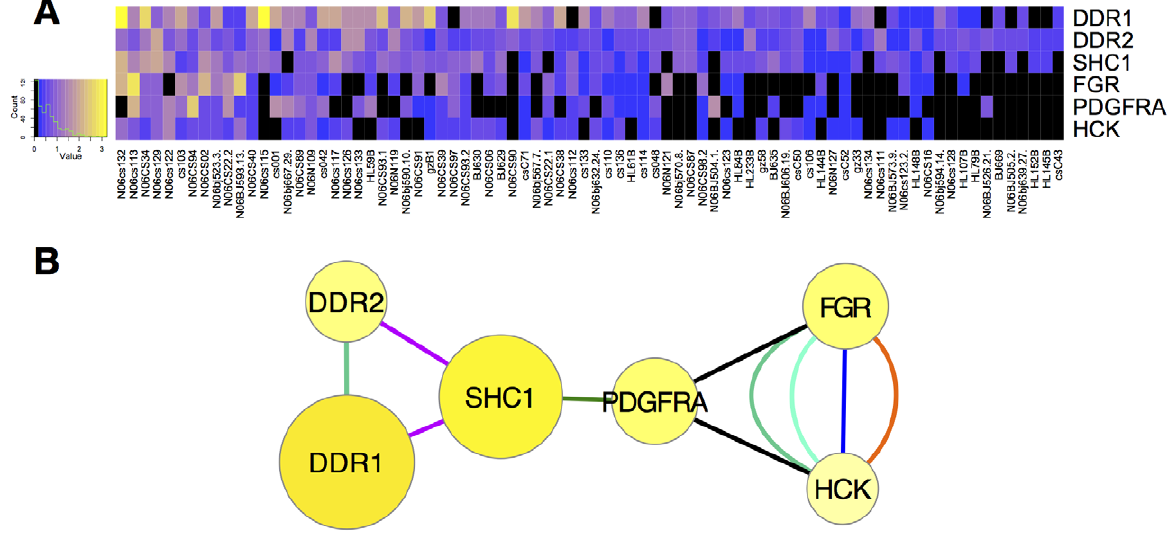
Figure 6. Filtered cluster containing DDR2. ( A ), graphed as a heat map; and ( B ), graphed as a network as in Figure 5, except additional edges are included from GeneMANIA: black – genetic interactions; dark turquoise – shared protein domains; violet – physical interactions; green – pathway; and String: light turquoise – homology; orange – knowledge; and blue – combined score. SHC1 was included because it connected the network for these proteins for which limited interaction data is known.